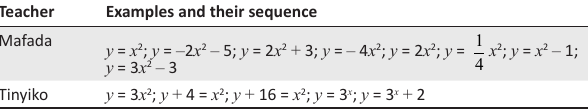
TABLE 7: Sequences of examples in Mafada’s and Tinyiko’s